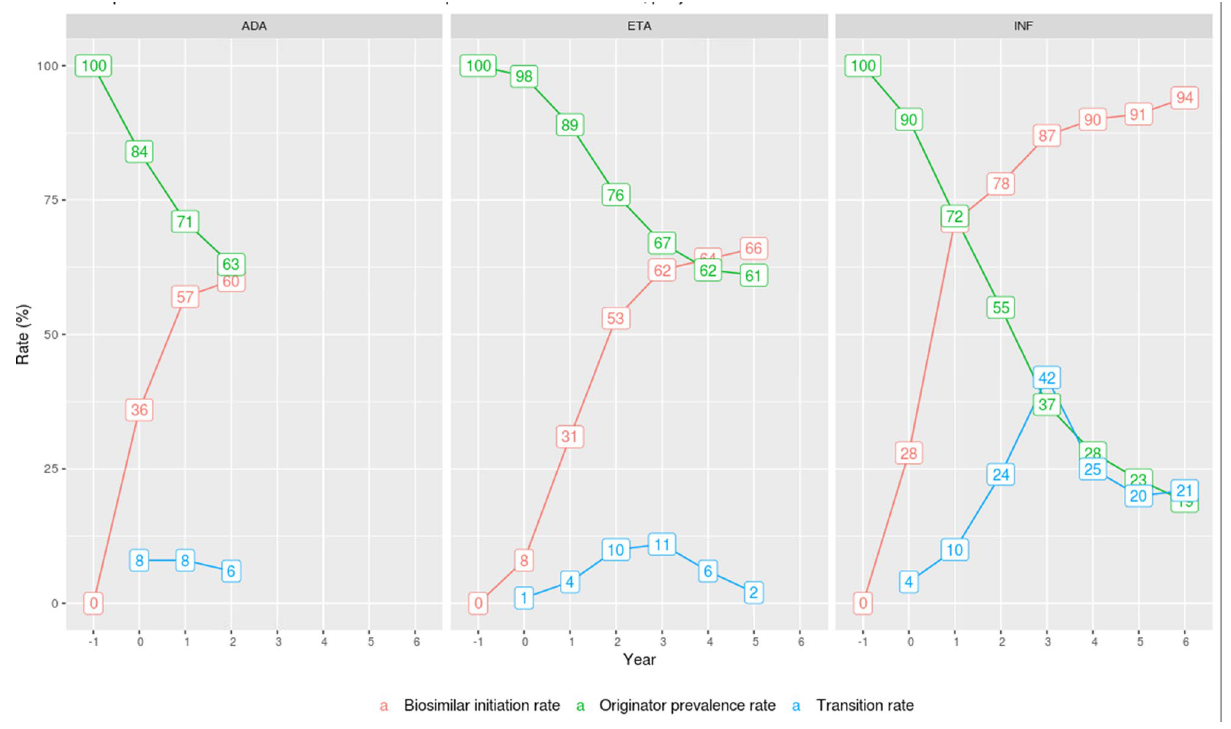
Figure 2. TNF-alpha inhibitors’ biosimilar initiation rate, originator prevalence rate and transition rate between year − 1 and 6 (if applicable) after first biosimilar entry for each molecule. ADA, ETA and INF refer to adalimumab, etanercept and infliximab respectively.